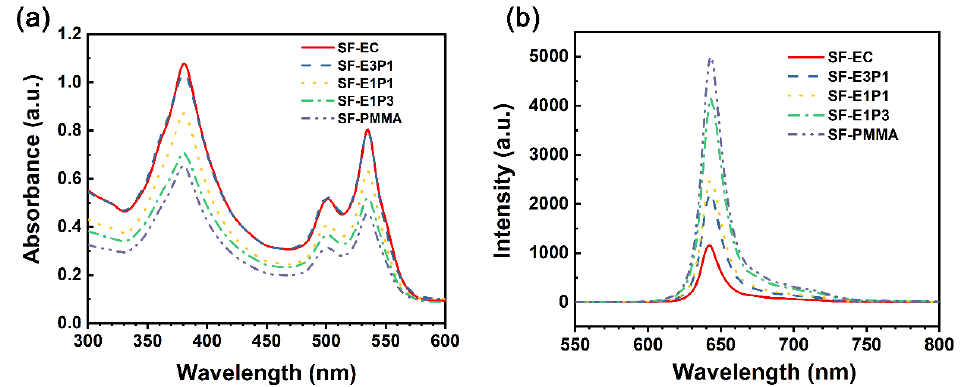
Figure 6. ( a ) Absorption spectra and ( b ) emission spectra of the sensing films with different polymer matrices under ambient conditions.